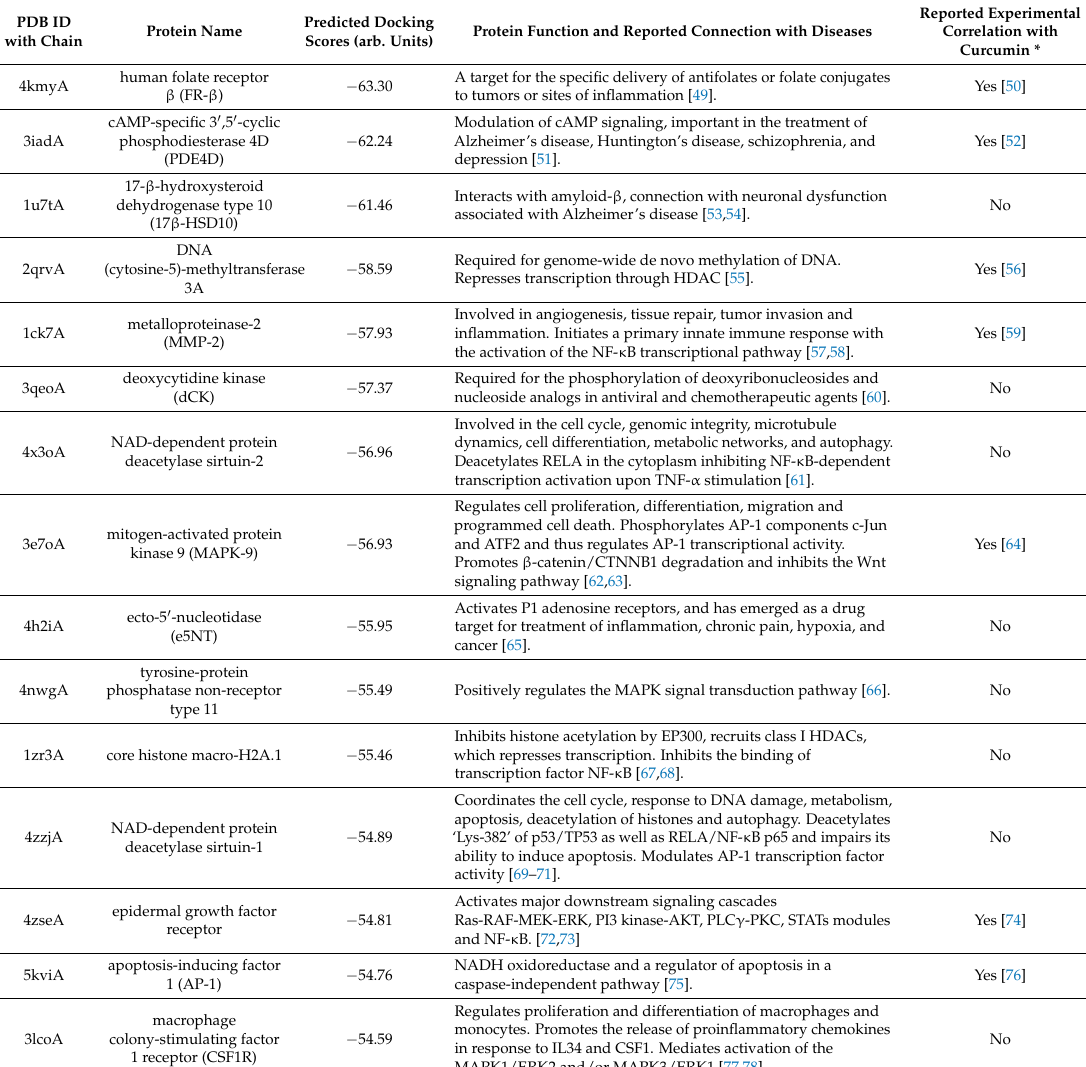
Table 1. Identified curcumin’s protein targets using the developed inverse molecular docking protocol against human